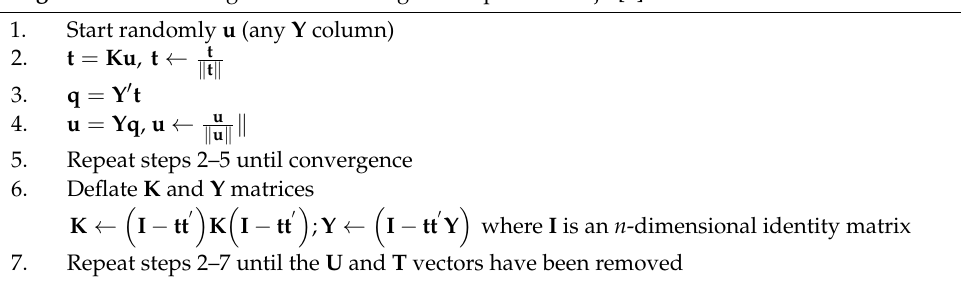
Algorithm 1. KPLS algorithm according to Rosipal and Trejo